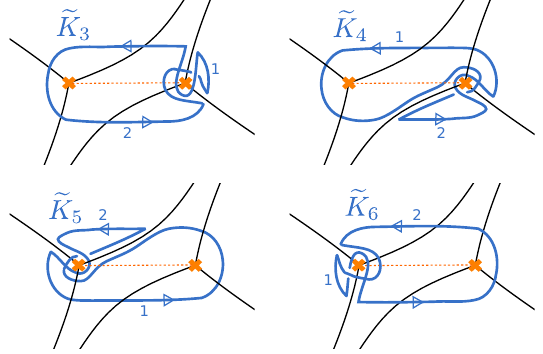
Figure 29 . Four lifts of K to e C which contribute to F ([ K ]).